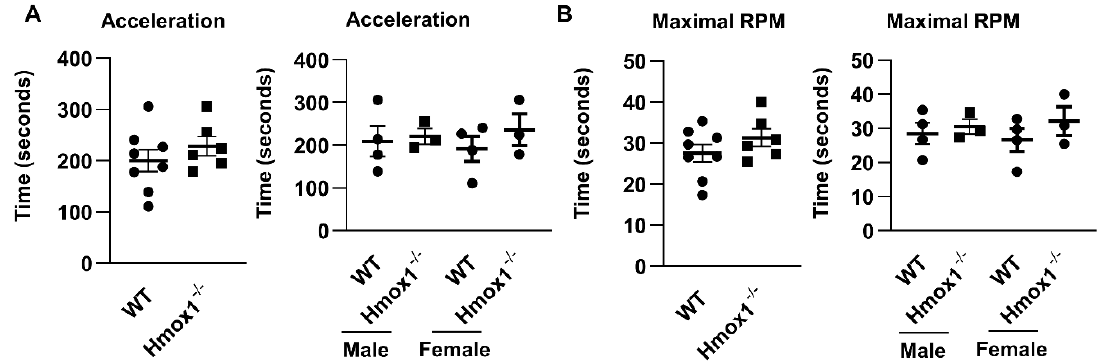
Figure 3. No changes in motor coordination between Hmox1 -/- mice and WT littermates. Motor coordination was measured using the rotarod test in Hmox1 -/- mice and WT littermates (4–5 months old). Riding time was recorded when the rotarod was hold accelerated (acceleration, A ) or at the maximal speed ( B ). Data are expressed as mean ± SEM. n = 6–8.